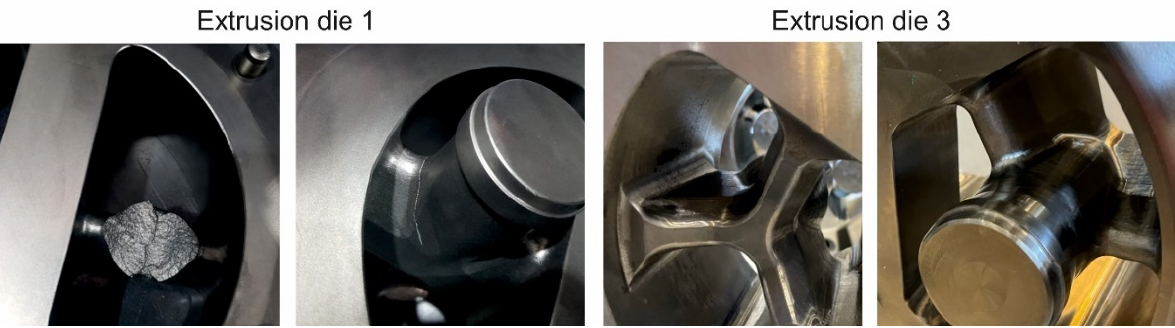
Figure 15. Porthole dies after extrusion of tubes of Ø50 × 2 mm from 7021 alloy; broken mandrel view for extrusion die 1 (on the left), bridge and mandrel view for extrusion die 3, free from cracking (on the right).